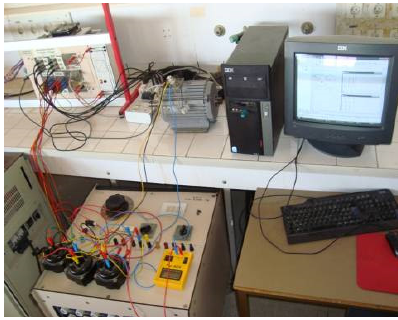
Figure 7. Experimental setup.